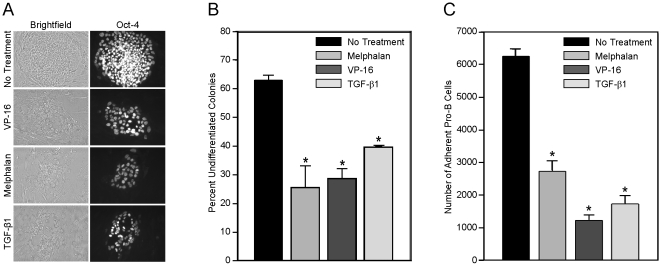
Exposure of HOB to chemotherapeutic agents or rTGF-β1 diminished the ability of HOB to support human embryonic stem cells and decreased pro-B cell interaction with HOB.
A) HOB were pre-exposed to melphalan [50 µg/ml], VP-16 [50 µM] or rTGF-β1 [10 ng/ml] for 24 hours. The HOB were rinsed thoroughly and human embryonic stem cells were added in co-culture with the HOB. After 2 days of co-culture, stem cell colonies were counted, stained for Oct-4 as an indicator of pluripotent potential and B) designated as undifferentiated or differentiated based on classic morphology of well defined borders. C) To determine if exposure of HOB to chemotherapeutic agents or rTGF-β1 affected pro-B cell adherence, HOB were exposed to melphalan [50 µg/ml], VP-16 [50 µM] or rTGF-β1 [10 ng/ml] for 24 hours. Adherent layers of HOB were rinsed thoroughly and co-cultured with fluorescently labeled pro-B cells (1×105). After 24 hours the media was aspirated and non-adherent pro-B cells were gently rinsed. Remaining HOB and pro-B cells adherent to the HOB layer were trypsinized and events counted on high flow rate for 30 seconds to enumerate number of pro-B cells attached to the HOB. *p<0.05.